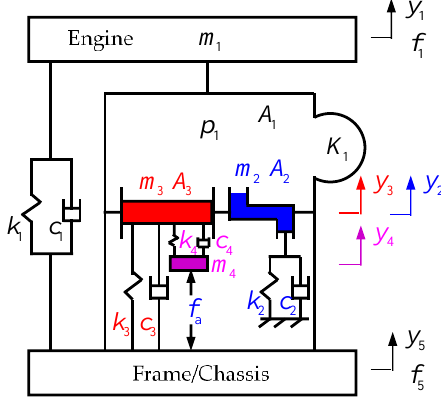
Figure 4. Mechanical model for AHM-SNA.